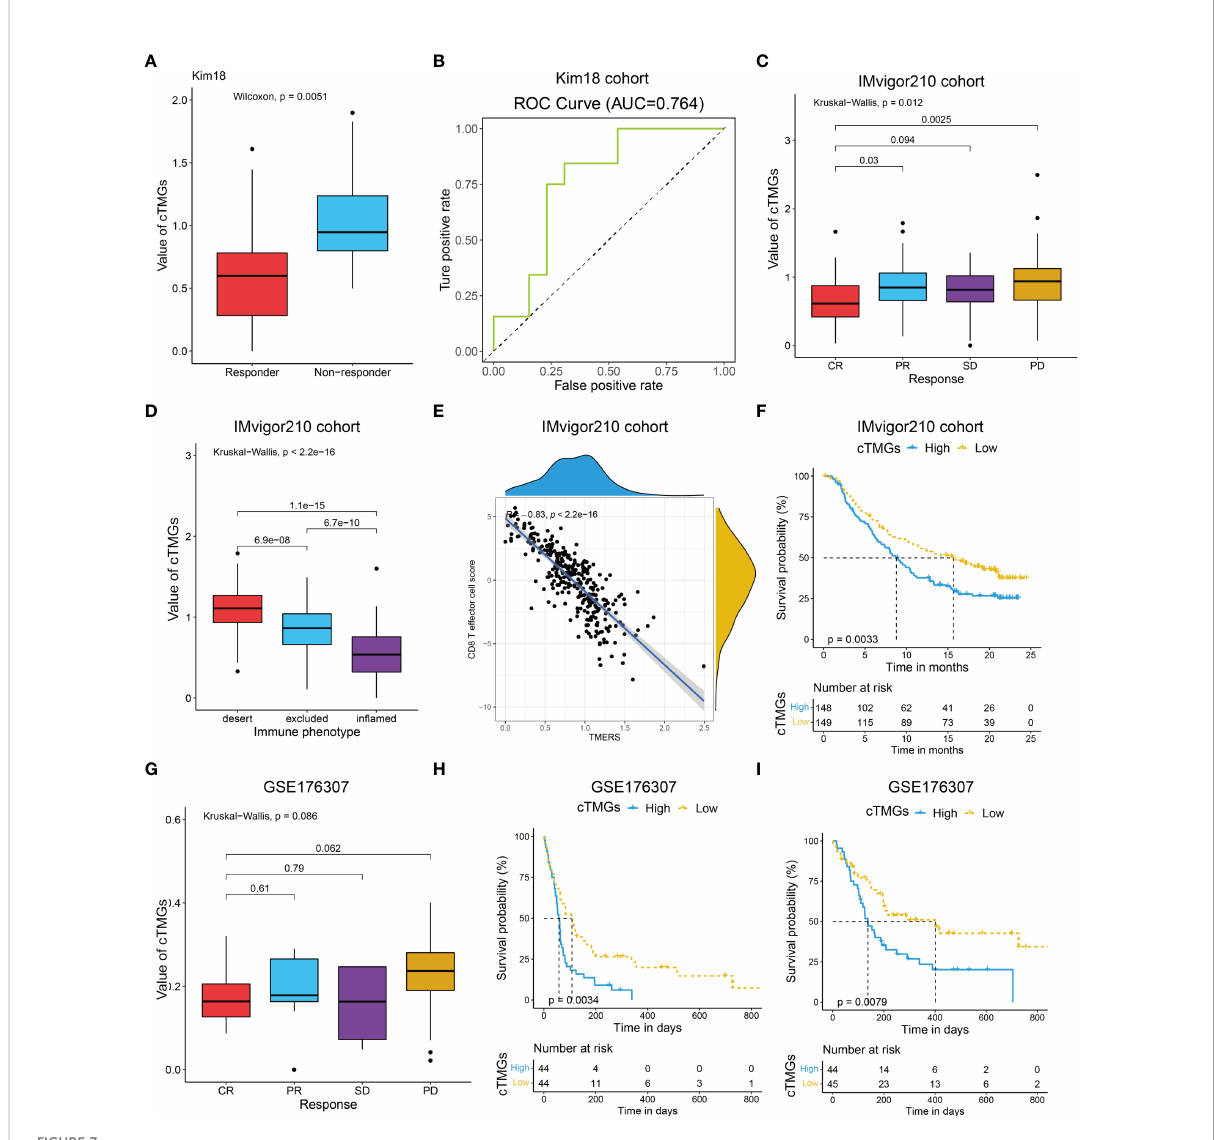
FIGURE 7 Performance of the cTMGs for predicting the effect of ICI therapy on non-CM patients. (A) Box plot showing a difference in the value of cTMGs across the two response subtypes for patients with gastric cancer in the Kim18 cohort. (B) ROC curve showing the performance of the cTMGs for predicting the effect of pembrolizumab therapy on patients with gastric cancer in the Kim18 cohort. (C) Box plot showing differences in the value of cTMGs across the four response subtypes of the IMvigor210 study. (D) Box plot showing differences in the value of the cTMGs across the three immune phenotype subtypes of the IMvigor210 study. (E) Scatter plot showing the correlation between CD8 T effector cell score and cTMGs in the IMvigor210 study. (F) OS of patients with UC in the IMvigor210 study strati fi ed by cTMGs subtype classi fi cation. (G) Box plot showing differences in the value of cTMGs across the four response subtypes for the GSE176307 dataset. (H, I) OS (H) and PFS (I) of patients with UC in the GSE176307 dataset strati fi ed by cTMGs subtype classi fi